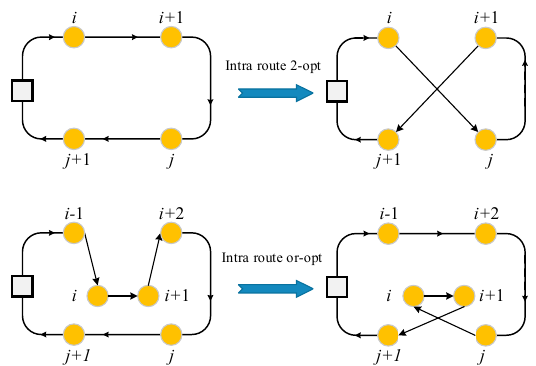
Figure 5. An example of intraroute 2-opt and intraroute or-opt.